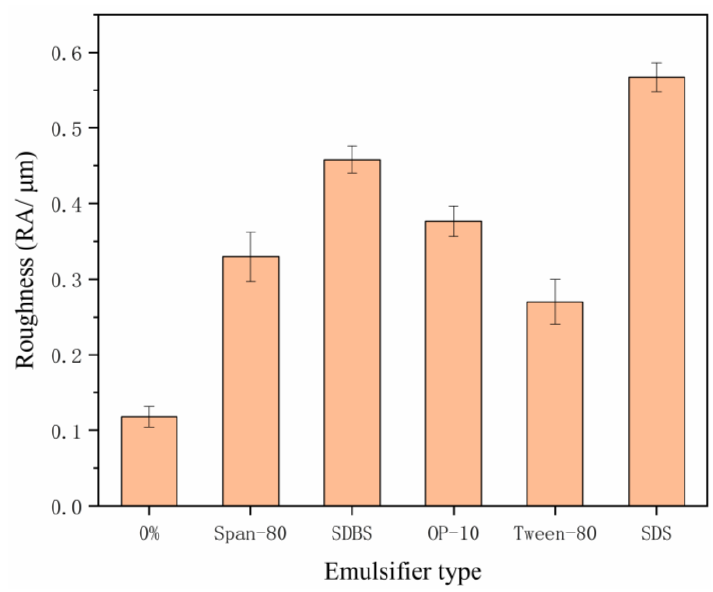
Figure 8. Effect of emulsifier on film roughness.